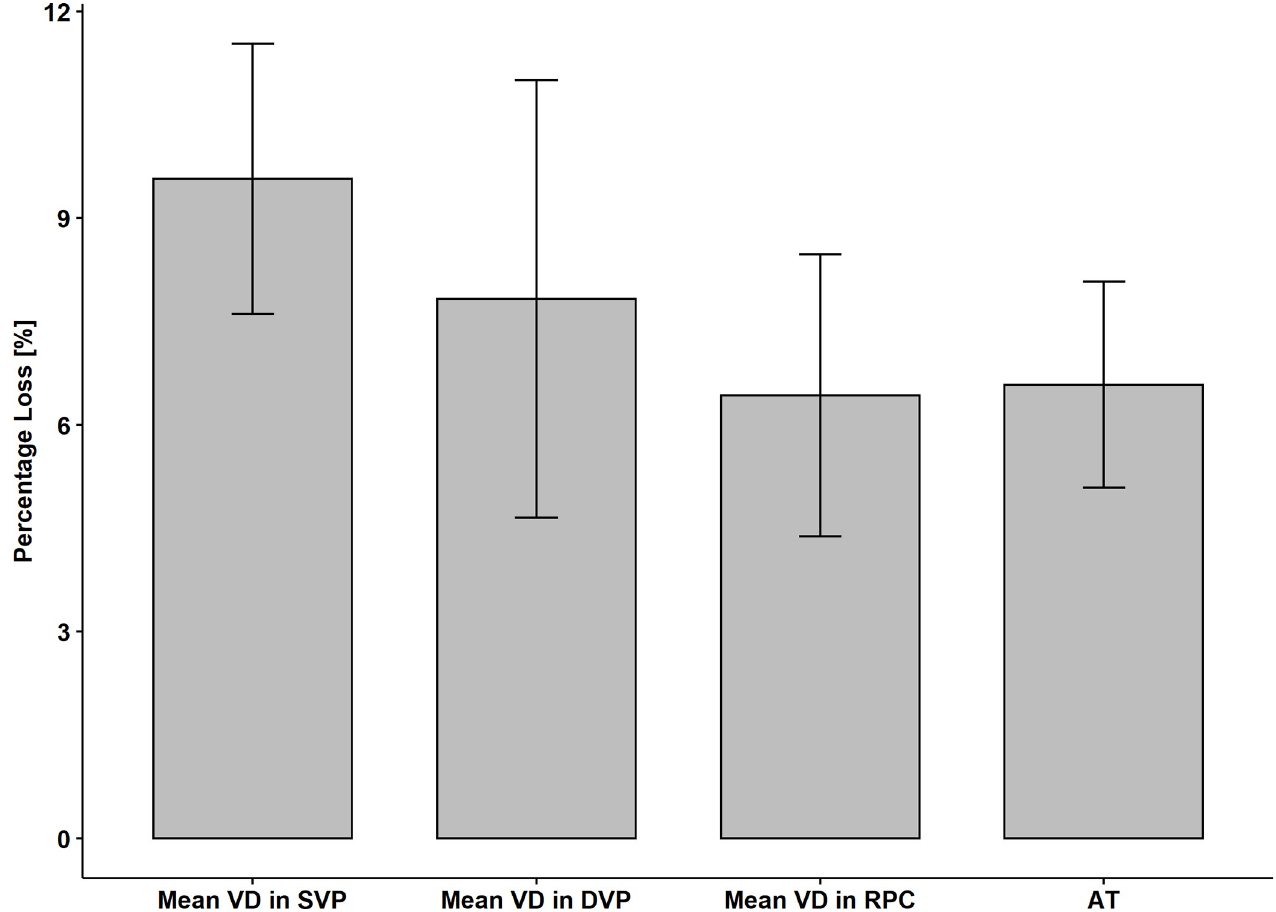
Fig 3. The box plot presents a direct comparison of the percentage loss of vessel density and average threshold of the retinal sensitivity after scleral buckling surgery for macula-on retinal